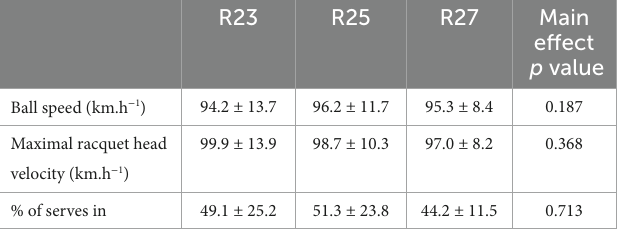
TABLE 2 Serve performance for the different racket conditions (mean ± SD).